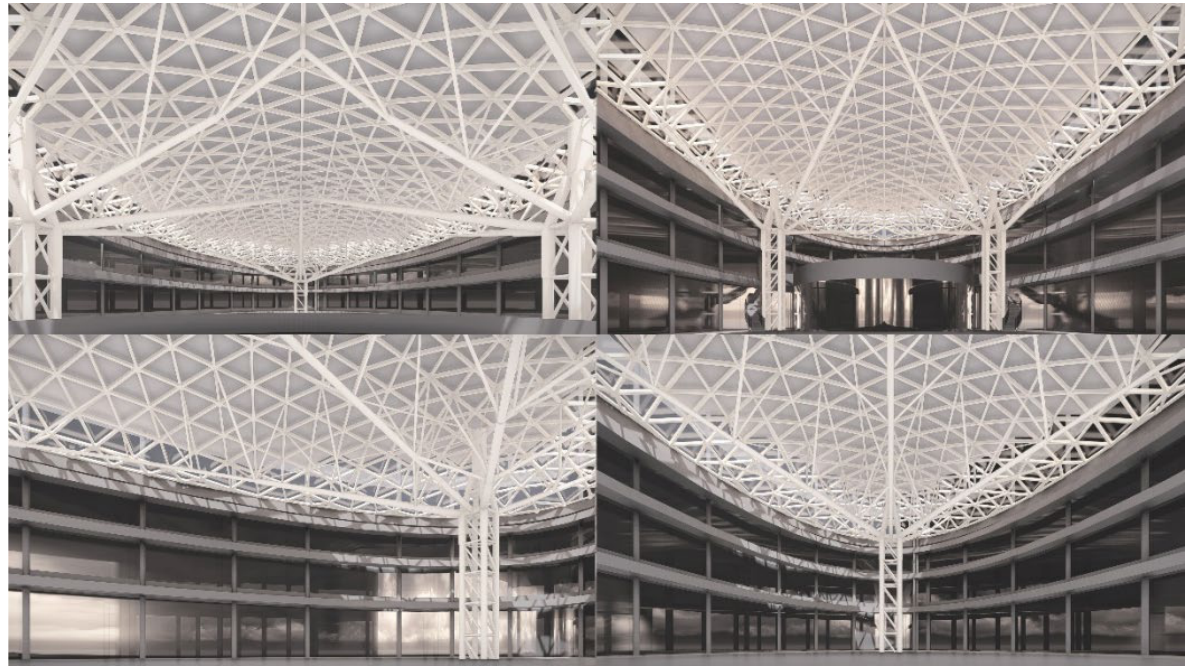
Figure 6. The floating and under-the-trees feeling of the design.